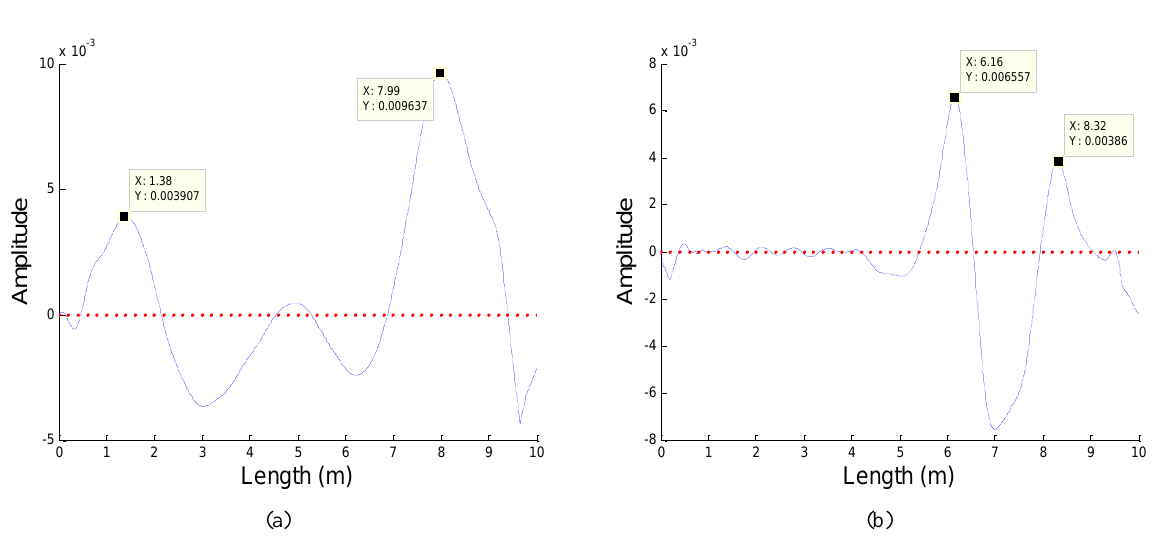
Fig. 8. IMF 1 with δ = 0.3 at 4 m and 8 m and (a) SNR = 10 and (b) SNR = 5.